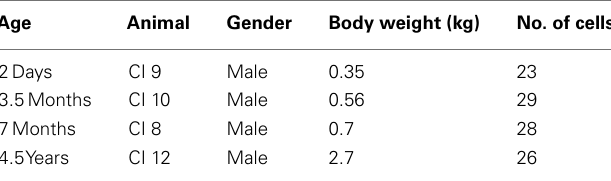
Table 1 | Age, weight, gender, and number of pyramidal cells injected in the animals used in the present